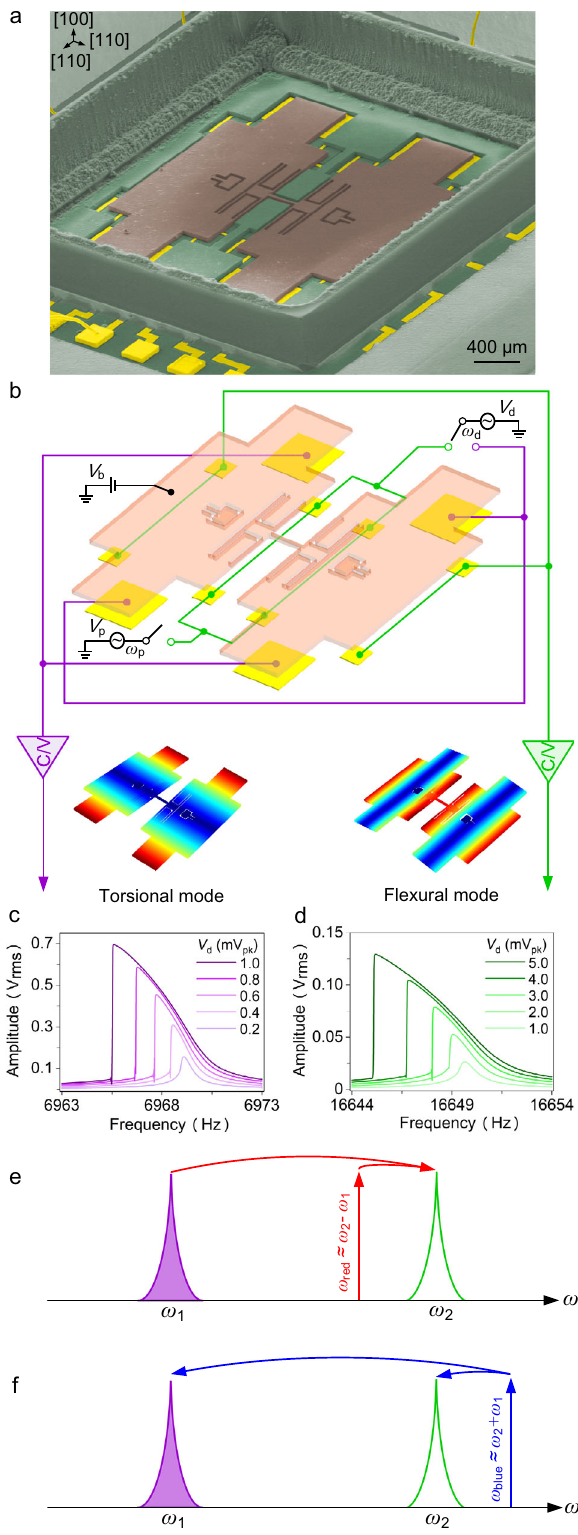
corresponds to the mode of interest (torsional mode, which we intentionally drive into nonlinear vibration, with α 1 being the Duf fi ng coef fi cient, and F d cos( ω d t ) being the harmonic driving force), and i = 2 corresponds to the phonon cavity ( fl exural mode, which remains undriven). The energy dissipation rates are given by γ i , and c ij ( i , j = 1, 2) give the intra-modal ( i = j ) and